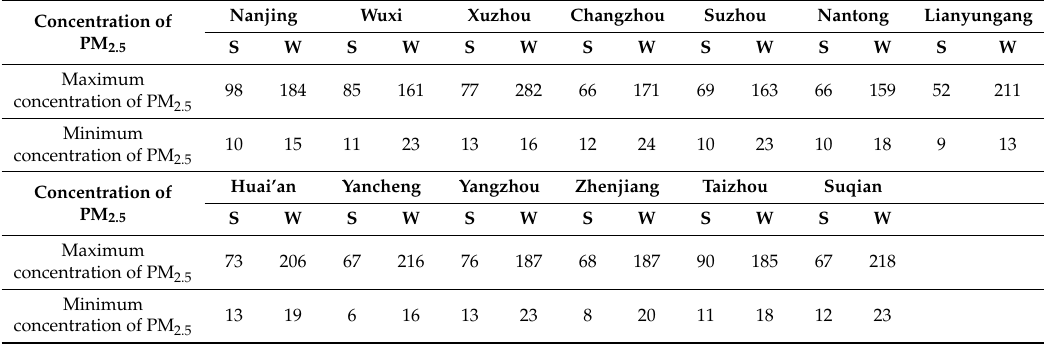
Table 1. The highest and lowest concentrations of PM 2.5 in summer and winter in 13 cities in Jiangsu Province in 2016.